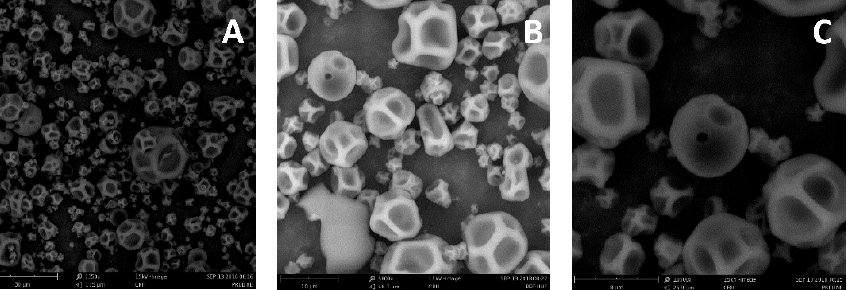
Figure 1. SEM photomicrographs of spray-dried encapsulates corresponding to the WPI/MDX sys- tems: ( A ): magnification of 2350×; ( B ): magnification of 5800×; ( C ): magnification of